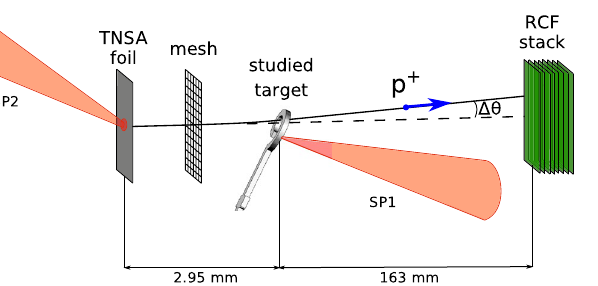
Figure 2. Sketch of the experimental setup for magnetic field generation and proton radiography measurements with two laser beams—SP1 and